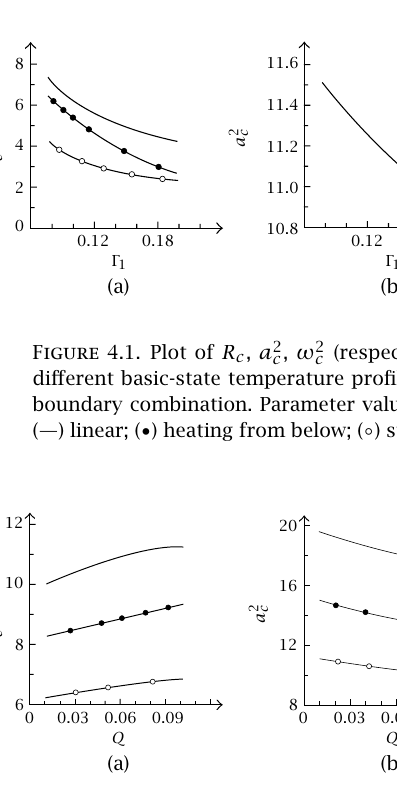
Figure 4.2 . Plot of R c , a 2 c , ω c (respectively, (a), (b), and (c)) versus Q for different velocity boundary combinations with respect to linear basic tem- perature profile, f(z) = 1. Parameter values: Da = 5 . 0 , Λ = 0 . 9, and Γ 1 = 0 . 1. ( ◦ ) free-free; ( • ) free-rigid; (—) rigid-rigid.